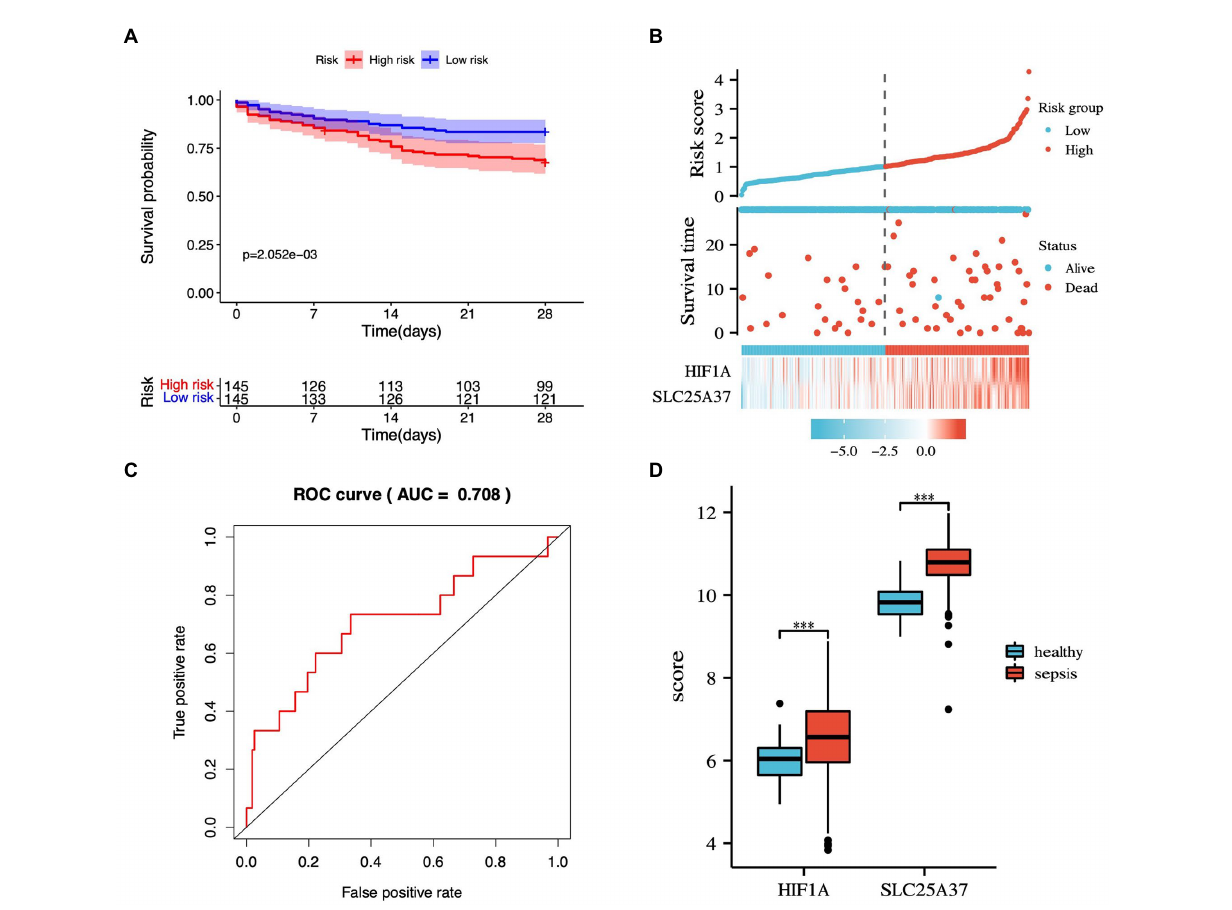
FIGURE 5 Prognostic prediction model based on common IMRGs. (A) Kaplan–Meier survival curves of 28-day mortality between high- and low-risk groups ( p = 2.052e-03). (B) The risk score analysis between high-risk and low-risk groups and survival status analysis. (C) The receiver operating characteristic (ROC) curve of the two-gene model in patients with sepsis and controls (AUC:0.708). (D) The expression of the two genes between sepsis and healthy